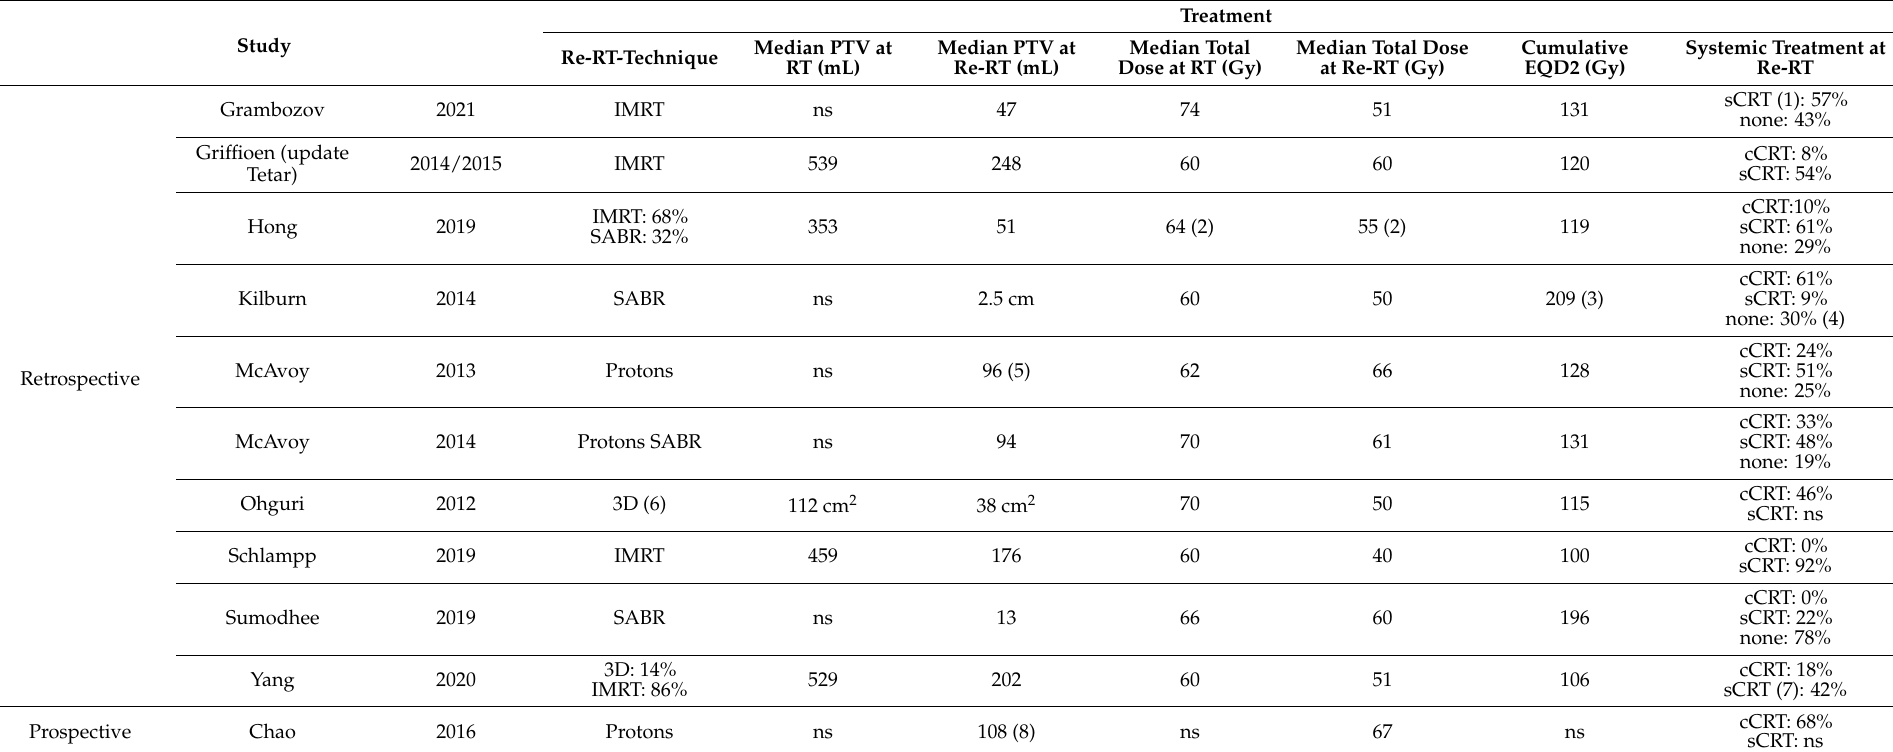
Table 2. Parameters regarding radiation technique, treatment volume and dose as well as systemic treatment.